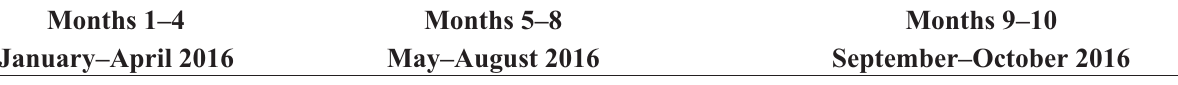
Table 1. Duration of Project/Time